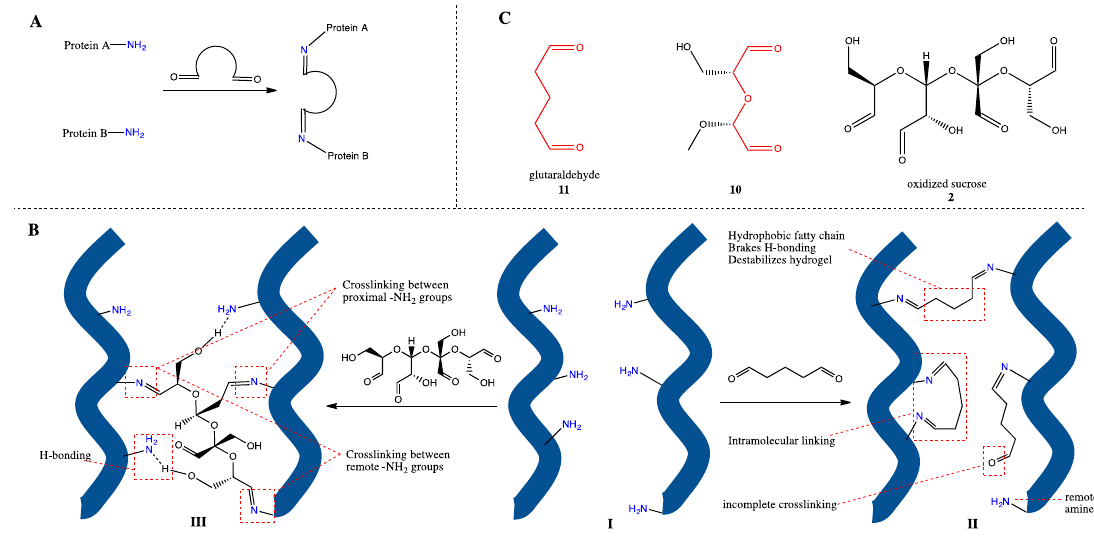
Figure 2. Mechanism of crosslinking. ( A ) Concept of the crosslinking process. ( B ) Crosslinking protein chains with glutaraldehyde (I → II) and oxidized sucrose (I → III). ( C ) Compound 10 resembles partial features of both glutaraldehyde (11) and oxidized sucrose (2).